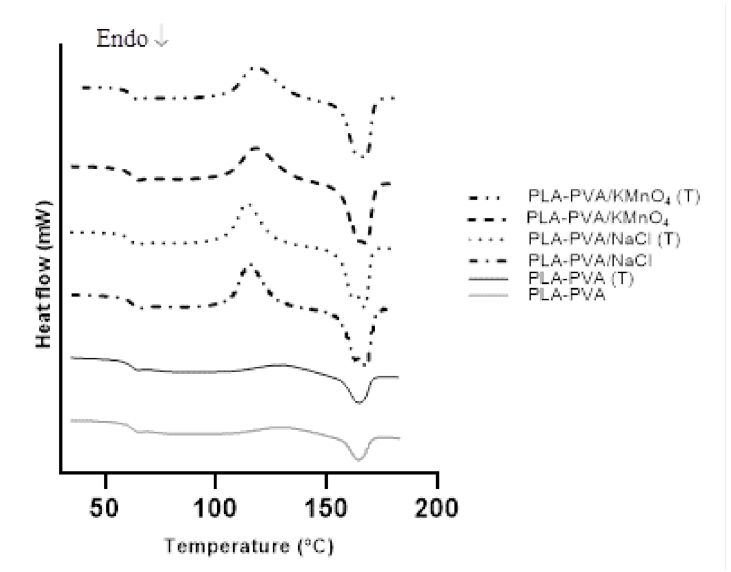
Figure 3. DSC curves of porous PLA bioscaffolds.